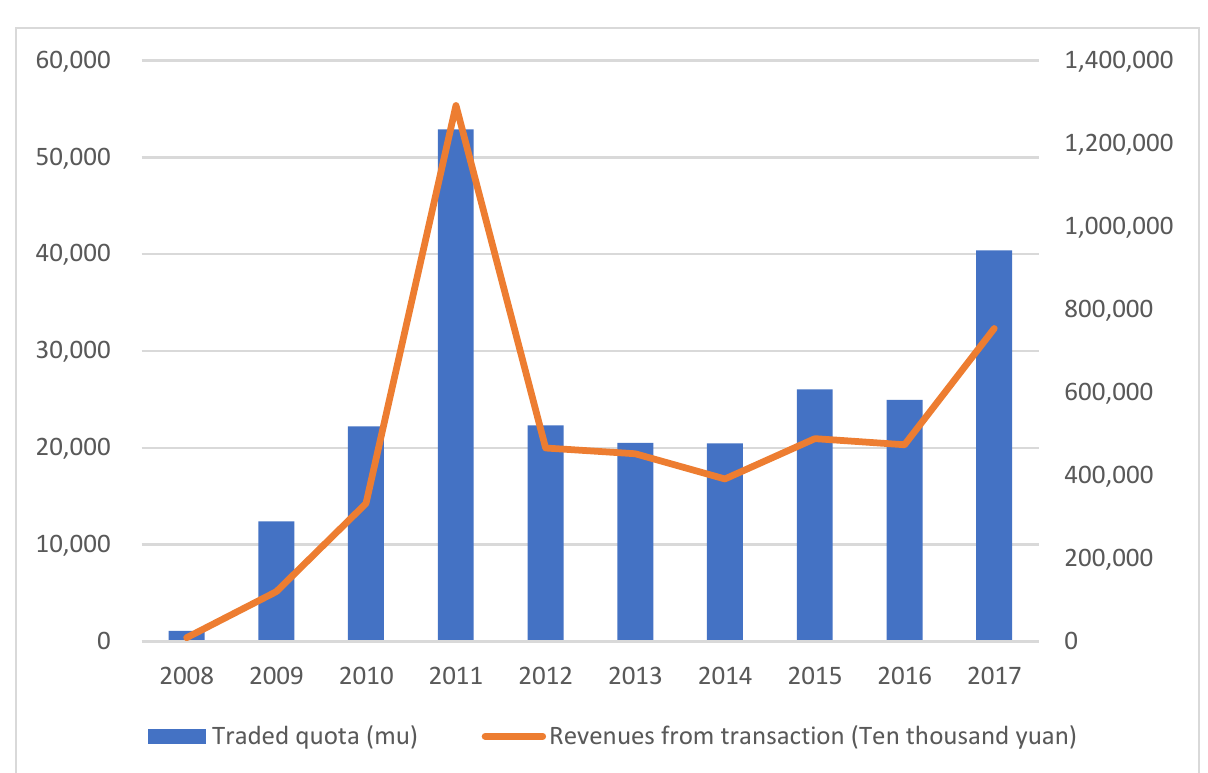
Table 1. Data sources and description.